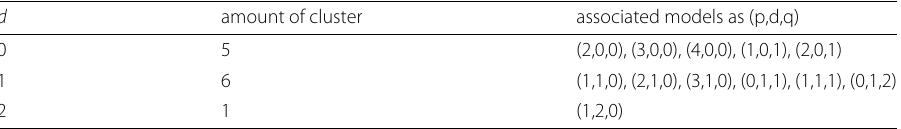
Table 1 Clusters grouped by d d amount of cluster associated models as